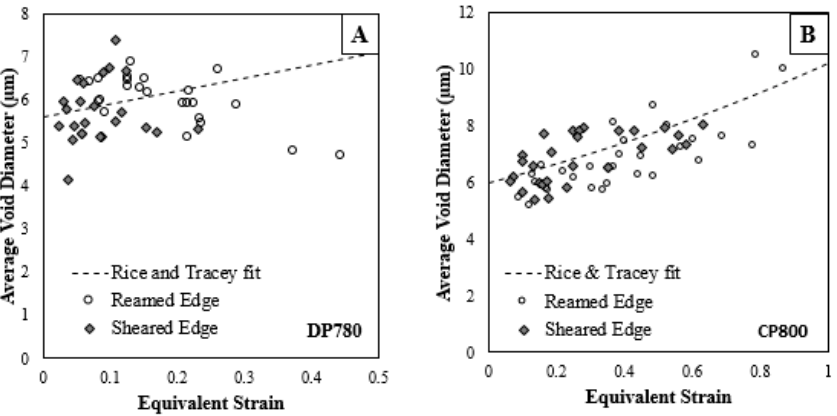
Figure 25. Evolution of void growth using Equation (6) for reamed and sheared edges of the ( A ) CP800 and ( B ) DP780 steels.